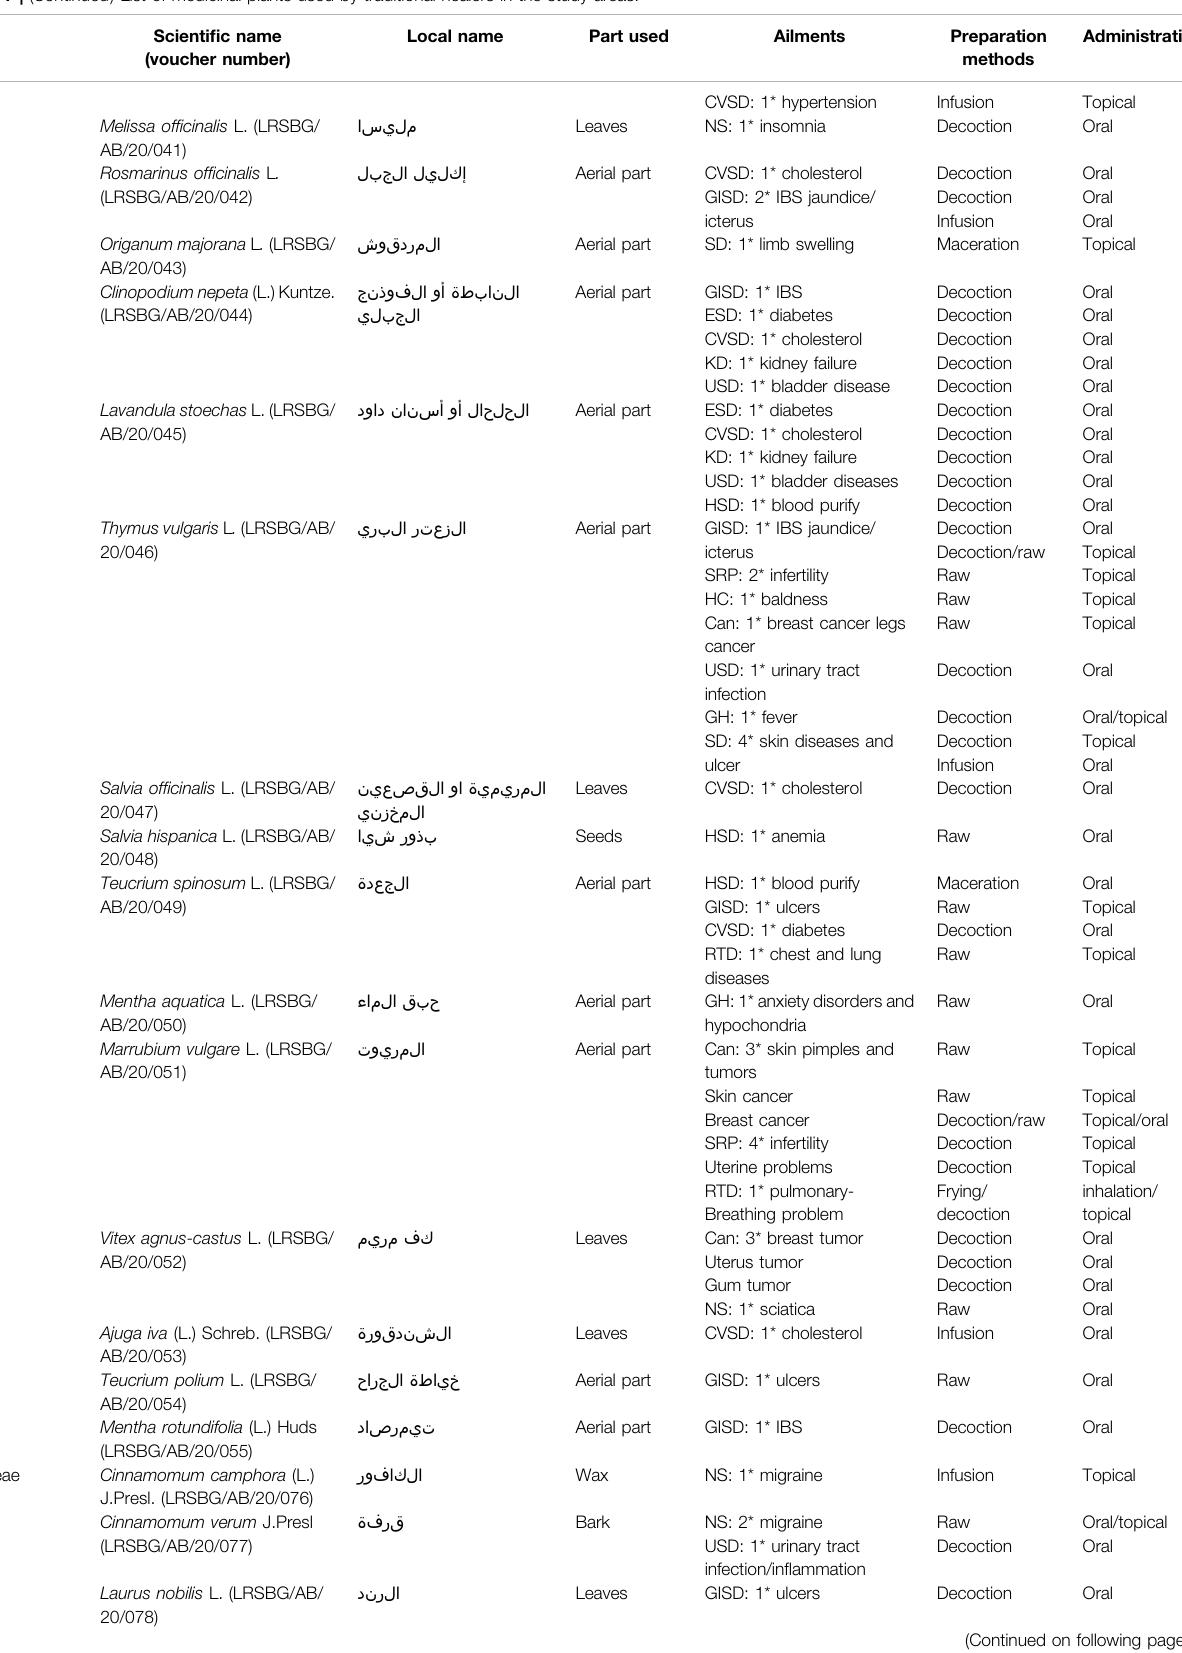
TABLE 7 | ( Continued ) List of medicinal plants used by traditional healers in the study